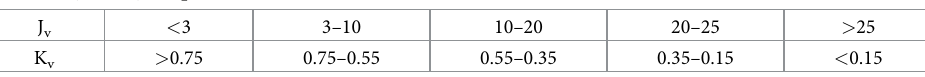
Table 1. J v and K v comparison